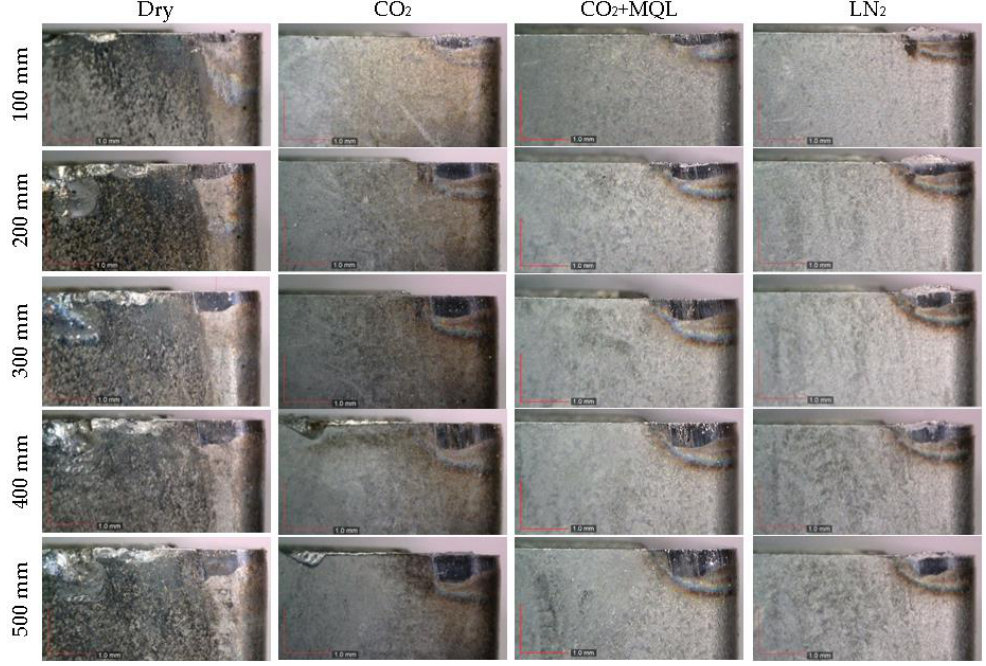
Figure 3. Images of progressive flank wear under various machining conditions.